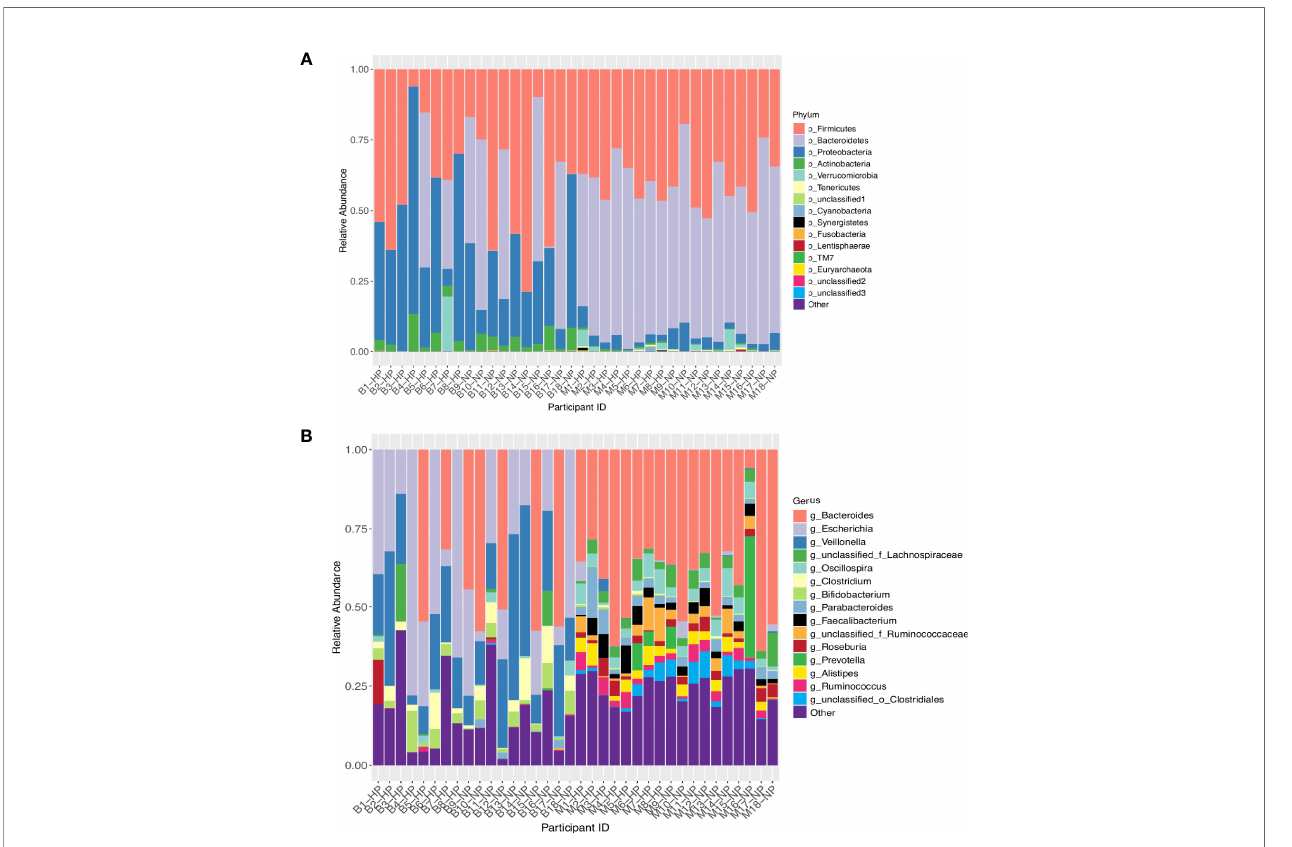
FIGURE 1 | (A) Relative abundance of the top 15 bacterial phyla. (B) Relative abundance of the top 15 bacterial genera. The X axis represents participants in the study. The Y axis is a scale of relative abundance out of 1. M, mother; B, baby; NP, normotensive pregnancy; HP, hypertensive pregnancy. Taxon levels are abbreviated with p, phylum; c, class; o, order; f, family; g, genus and s,